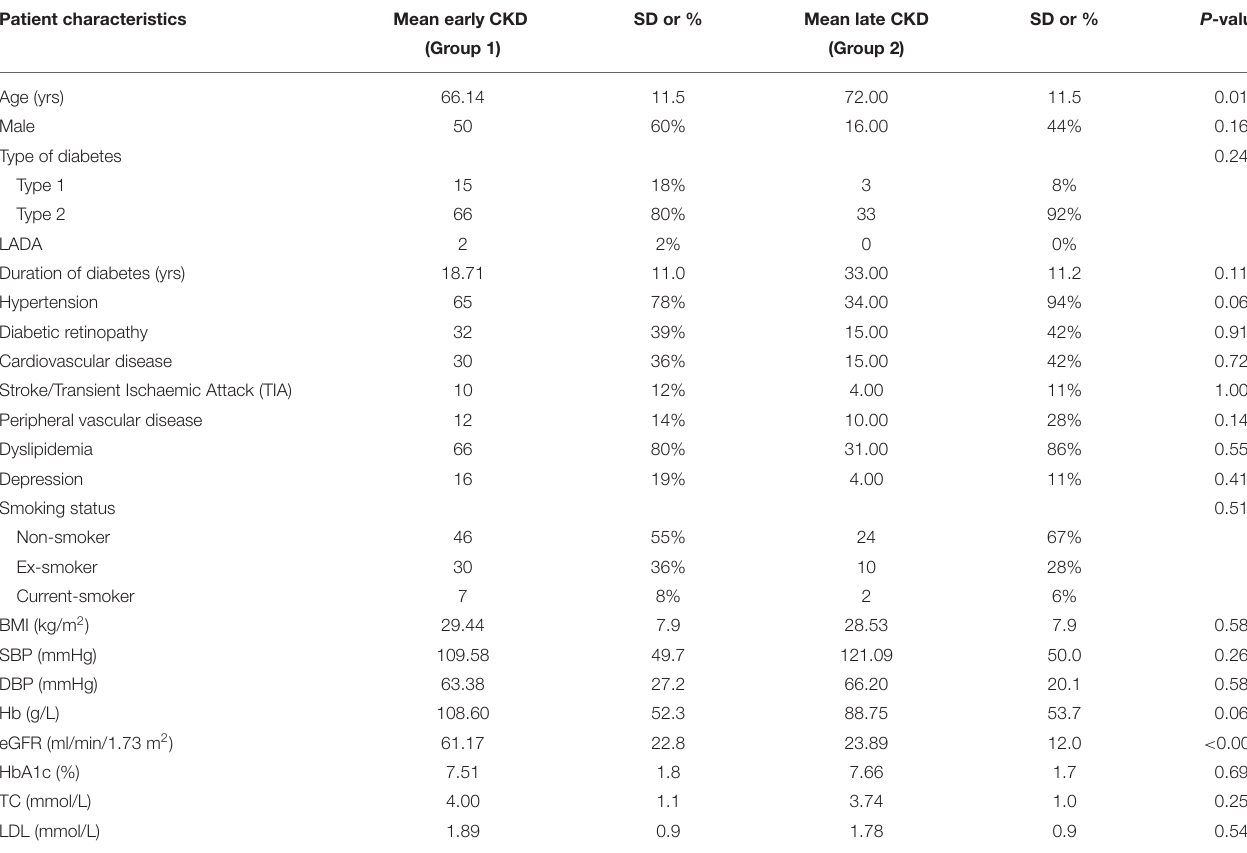
TABLE 1 | Clinical and biochemical characteristics of participants. Patient